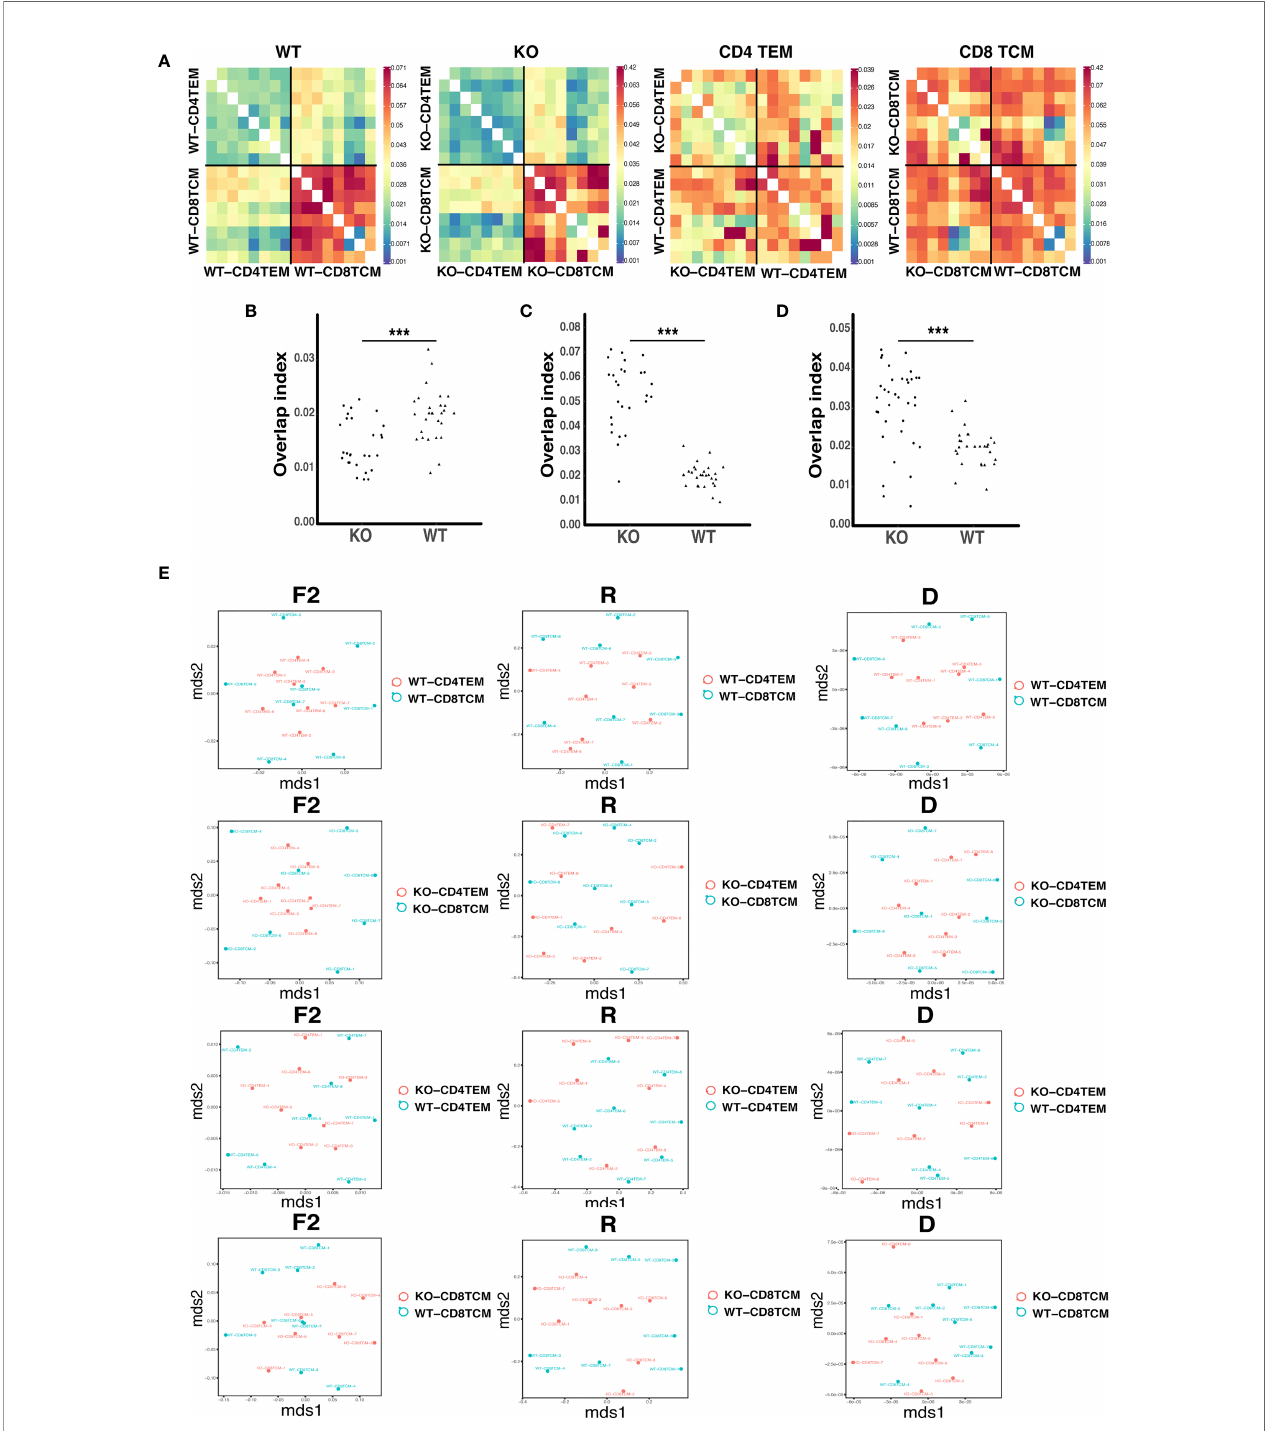
FIGURE 4 | The relative similarity of TCRV b repertoires in WT and KO chimeric mice. Heatmap represents the distance matrix of TCRV b repertoires of CD4 + TEM and CD8 + TCM cells in WT and KO chimeric mice (A) . Overlap indices for CD4 + TEM/CD4 + TEM (B) , CD8 + TCM/CD8 + TCM (C) and CD4 + TEM/CD8 + TCM (D) . Metrics F2, R and D for CD4 + TEM and CD8 TCM TRB sequences in WT and KO chimeric mice (E) . ***p <